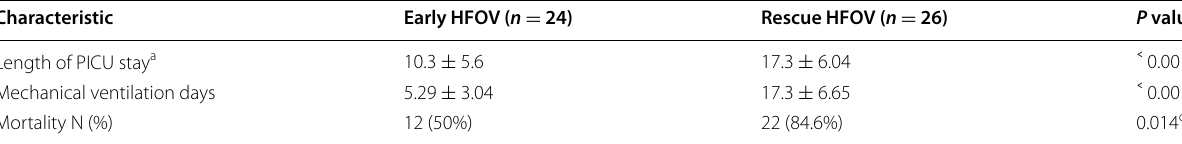
Values are presented as n (%) or mean a Length of stay in days b P value using T test